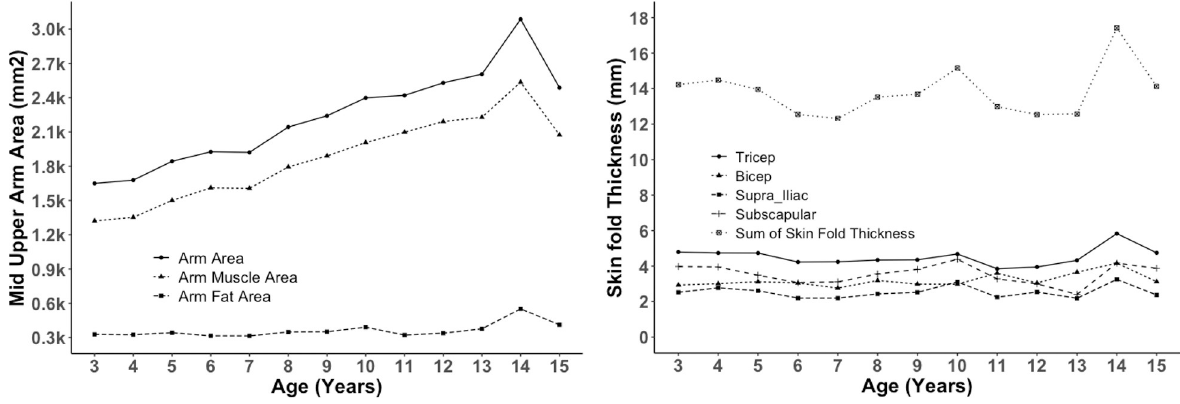
Fig 3. Trajectories of % body fat, fat mass, fat free mass and sum of skinfold thickness plotted against age in year (n = 330).